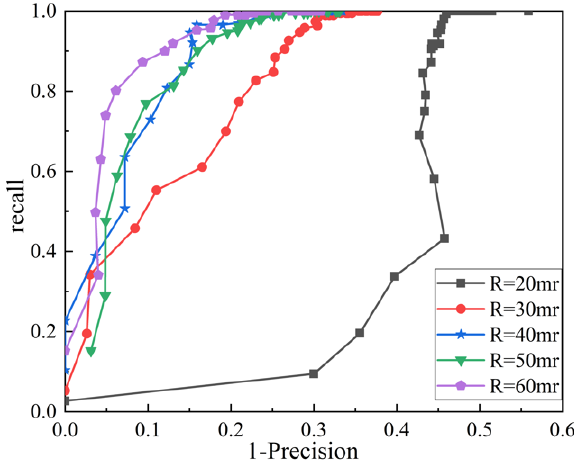
Figure 5. RP curves of different support radii. (2)